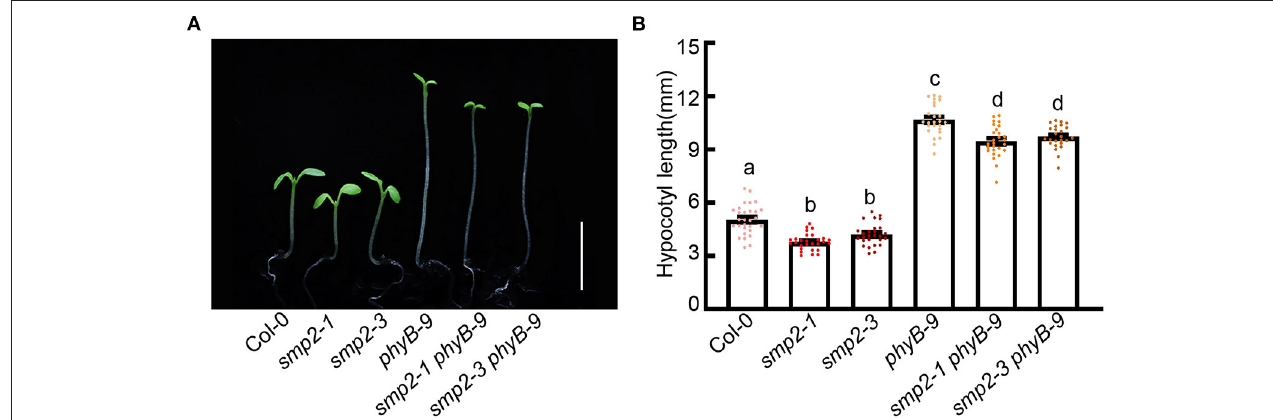
FIGURE 3 | SMP2 genetically acts downstream of phyB. (A) Visual phenotypes of wild-type (Col-0), smp2-1 , smp2-3 , phyB-9 , smp2-1 phyB-9 , and smp2-3 phyB-9 seedlings grown for 5 days in continuous red-light condition (145 µ mol · m − 2 · s − 1 ). Scale bars, 5mm. (B) Quantification of hypocotyl length of different seedlings as shown in (A) . Error bars represent SD, n ≥ 25. Letters above the bars indicate significant differences ( P < 0.05), as determined by one-way analysis of variance (ANOVA) with Duncan’s post-hoc analysis. Experiments were performed three times with similar